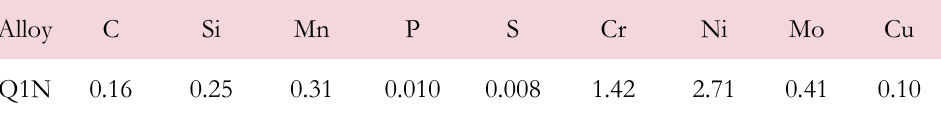
Table 1: Chemical composition in weight % of Q1N steel. The balance is Fe.